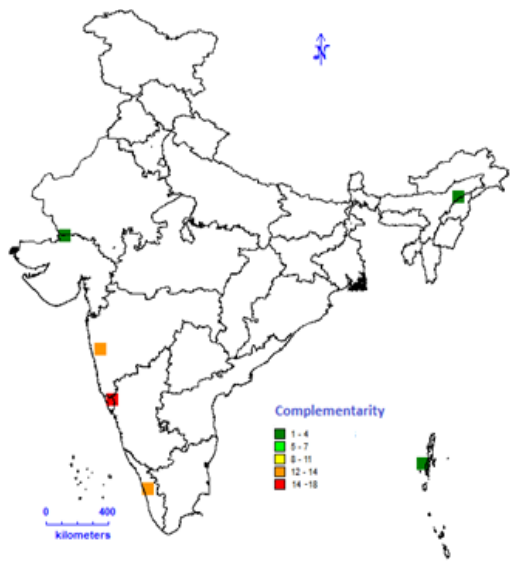
Figure 4. Species richness of 34 wild taxa of Vigna in 70 × 70 km grid cells.